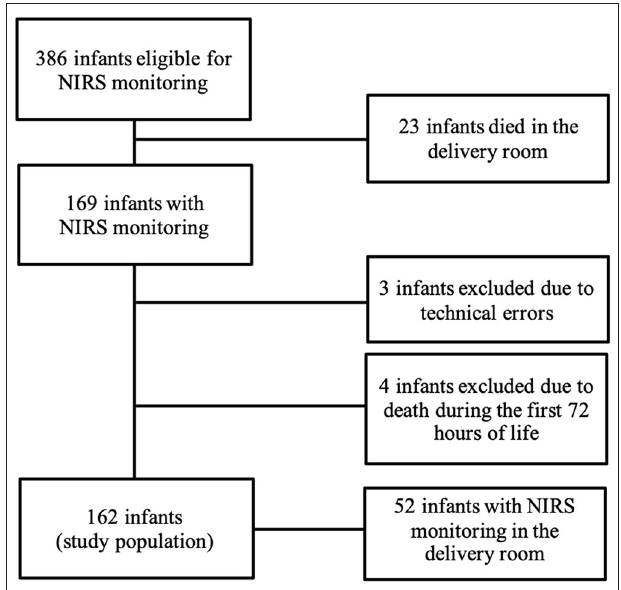
FIGURE 1 | Patient flow diagram of preterm infants recorded study at the neonatal intensive care unit at Ulm University Children’s Hospital during the study period between October 2010 and May